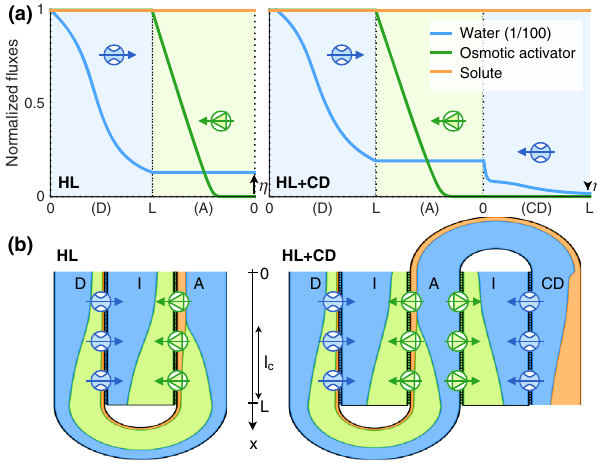
FIG. 2. Spatial distributions of the fluxes and molar fraction in the U -loop and full double loop (HL and HL þ CD models). (a) Fluxes of water (divided by a scaling factor of 100), osmotic activator (salt), and waste along the D and A limbs, left panel; and along the CD for the HL þ CD case; in this graph, the water loss =q in ratio η ¼ q out is the final normalized flux. (b) Spatial Water Water distribution of the molar fractions of water (divided by a scaling factor of 100), osmotic activator, and waste along the D and A limbs and in the interstitium. Note that in the (HL þ CD) double- loop geometry, the interstitium exchanges with all three branches (D, A, CD); although two were plotted for convenience, they have the same composition. Numerical data are calculated with parameters L ¼ 4 . 3 mm, P f ¼ 2500 μ m = s, n ¼ 1